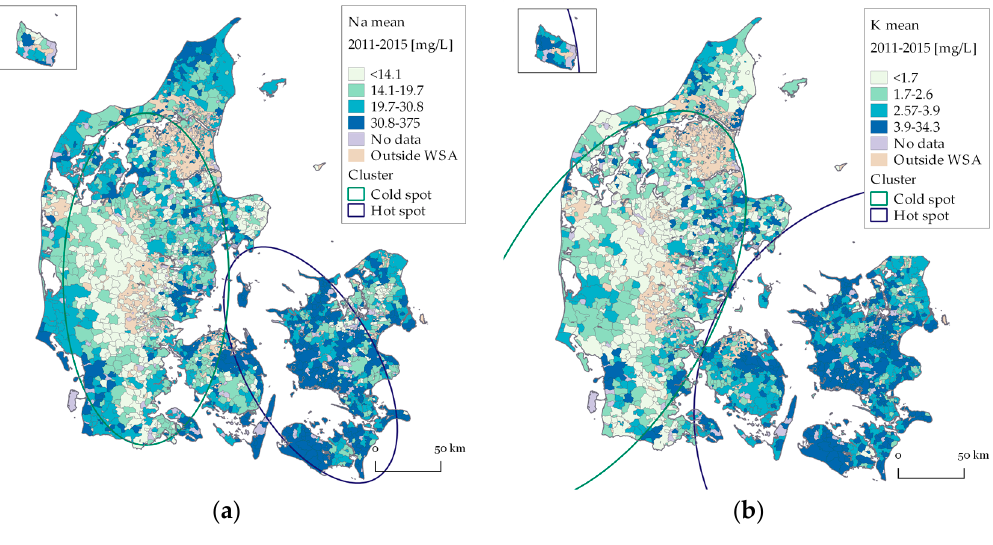
Table 1. Descriptive analysis of selected geogenic cations in drinking water in Denmark (1980–2017) given by means of number of drinking water samples, mean, median, 2.5% and 97.5% percentiles of the concentration for each of the cations Na, K, Mg and